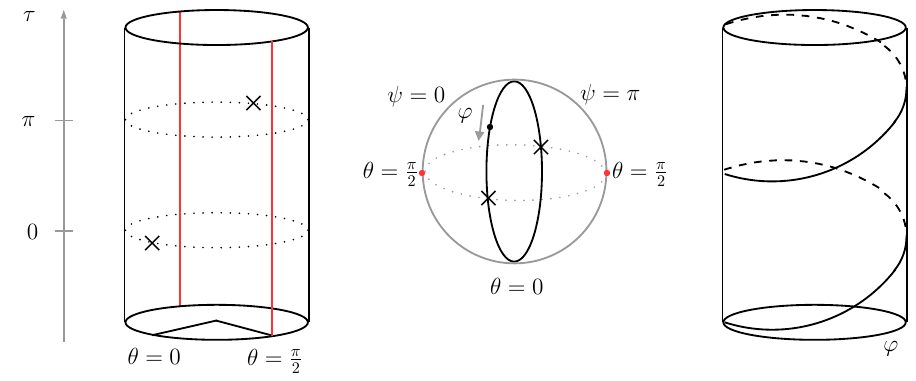
Figure 4 . A three dimensional version of the con(cid:12)guration discussed in the text. In red, the line defect marks two lines along (cid:28) at (cid:18) = (cid:25) and = 0 ; (cid:25) . The particle spins fast along the ’ 2